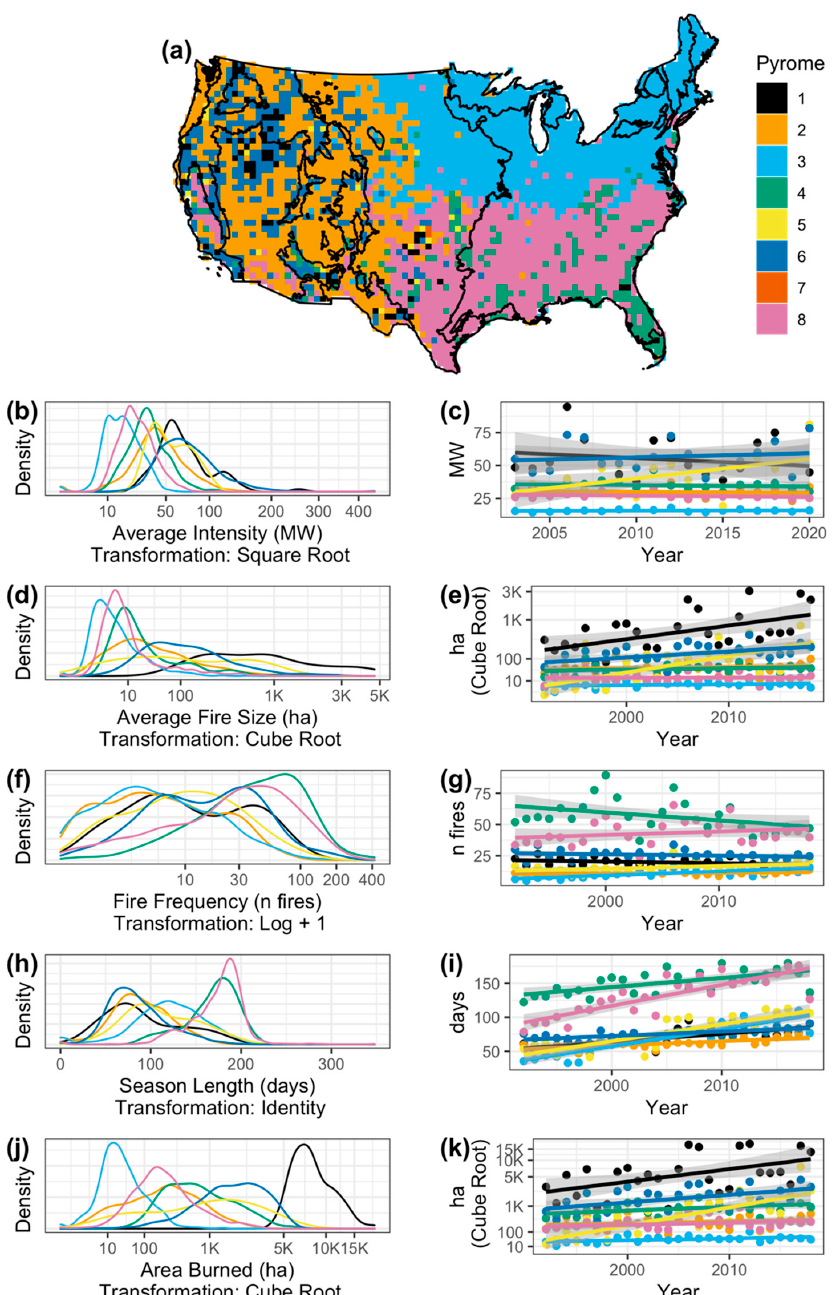
Figure 1. Pyrome classification scheme for k = 8 in the contiguous U.S. ( a ) The pyrome map with Environmental Protection Agency (EPA) Level 1 ecoregions displayed as black outlines. For each pyrome, the distributions and temporal trends are shown for the following characteristics (pyrome 7 was excluded due to insufficient sample size): ( b , c ) fire intensity (mean fire radiative power (FRP) from the Moderate Resolution Imaging Spectroradiometer (MODIS) in megawatts (MW)); ( d , e ) fire event size (mean area from the Fire Program Analysis fire-occurrence database (FPA-FOD) in hectares (ha); ( f , g ) frequency (number of fires from the FPA-FOD); ( h , i ) season length (2*sd Julian day from the FPA-FOD in days); and ( j , k ) burned area (sum area from the FPA-FOD in ha). All values are annual pixel means for each pyrome. For change over time, dots represent the average value for each year for each pyrome, and the trend lines (with error) were determined with linear regression. Black lines on the maps represent EPA Level 1 ecoregions.